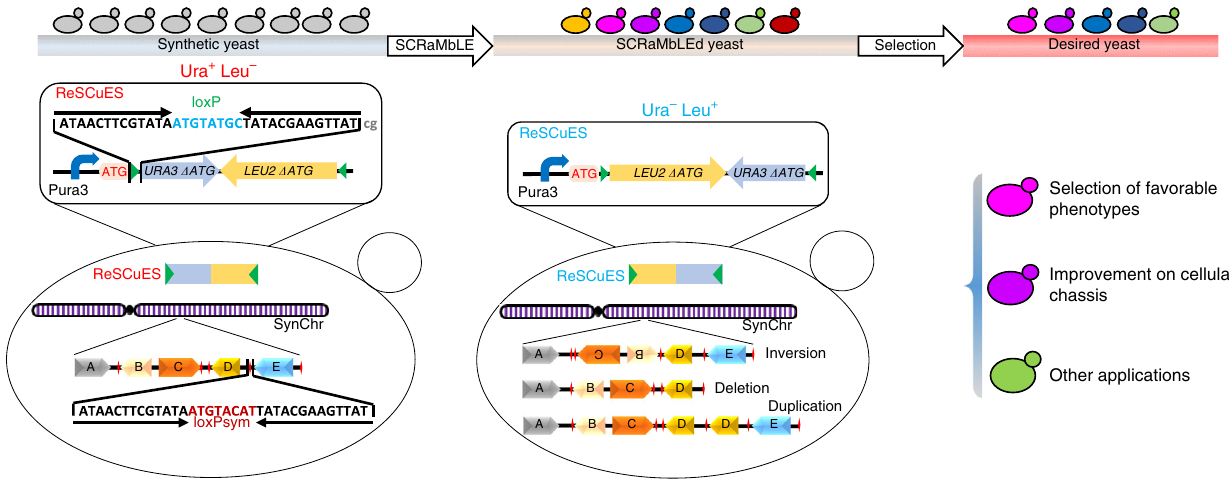
Fig. 1 Schematic overview of the work fl ow using ReSCuES and SCRaMbLE. On the left are a population of genetically identical cells containing ReSCuES and one or more synthetic chromosomes (Synthetic yeast). The composition of ReSCuES is illustrated in the rectangle. Pura3 represents the native URA3 promoter. ReSCuES could present in the yeast cells either in an episomal plasmid or integrated at a chromosome locus, rendering the cells as Ura + Leu − . SynChr, synthetic chromosome. Green triangle represents the loxP site. Red diamond represents the symmetric loxP site (loxPsym). In the middle are the SCRaMbLEd yeast strains selected by ReSCuES. Recombination between the two loxP sites inverts the markers, producing Ura − Leu + clones. Simultaneously, rearrangements happen in SynChr, leading to inversion, deletion, and duplication as depictured. In this population, the genome of each cell might be different, which is represented by different colors. On the right are the desired yeast strains after applying certain selection pressures, which could be strains with favorable phenotypes, improvement on cellular chassis and other